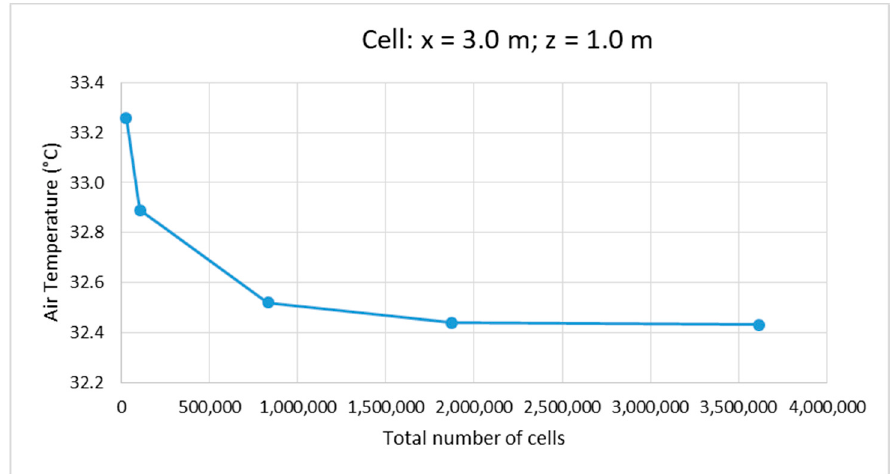
Figure 6. S ensitivity test of different network densities. Figure 6. Sensitivity test of different network